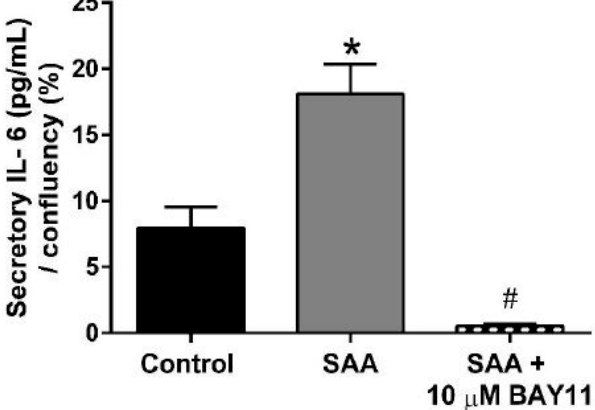
Figure 3. BAY11-7082 reduces secretory IL-6 induced by SAA. HCtAEC were treated with SAA and BAY11-7082 as defined in methods. A commercial ELISA kit was used to quantify levels of secretory IL-6 in the cell supernatant. All data was normalised to the corresponding level of cell confluence (expressed as a percentage %) determined using an IncuCyte system immediately prior to cell harvest for ELISA (See Supplemental Table S1 and Figure S4). Data represent the mean ± SD (n = 6 samples, each completed in duplicate; therefore, data represent 3 technical replicates). * Different to the control; p < 0.0001. # Different to SAA-treated cells; p < 0.0001.